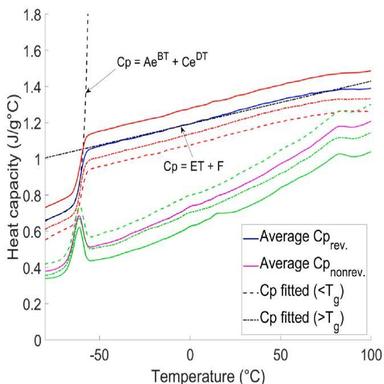
MDSC results for U-NR with model fits either side of the Tg.